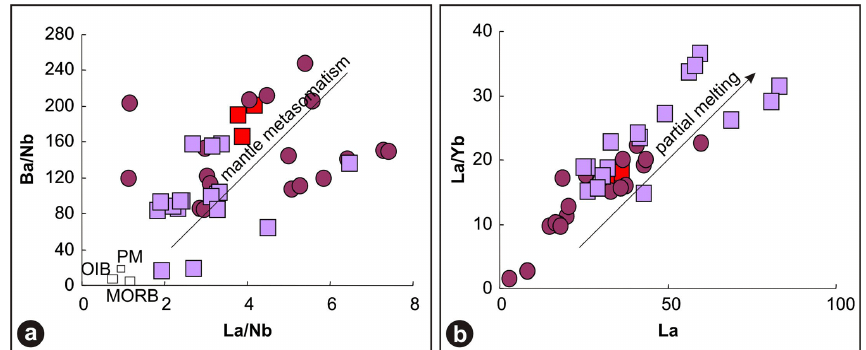
Fig. 18. (a) Ba/Nb vs. La/Nb diagram for the high-K island arc rocks. The data for N-MORB, OIB and PM are from Sun and McDonough (1989). (b) La/Yb vs. La diagram for the island arc rock units, illustrating the effects of partial melting and fractionation in their melt